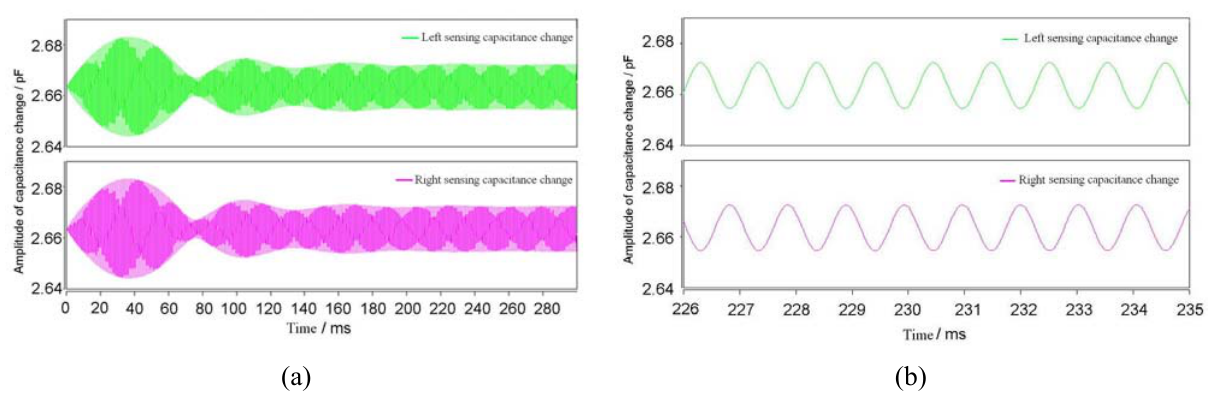
Figure 6. Transient change of the two sensing capacitances.